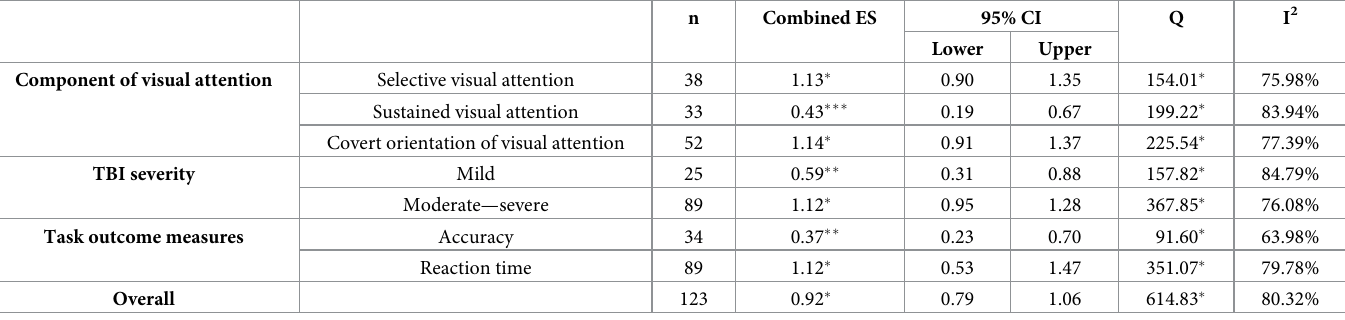
Visual attention following TBI. Table 4 reports the results of the overall ES and the com- bined ESs for different components of visual attention, TBI severity, and outcome measures, and these values are plotted in Fig 3. The 20 studies result in a total of 123 ESs represent differ- ent components of visual attention and conditions. The overall impact of TBI on visual atten- tion was significant and was large (ES = 0.92, SE = 0.09, p < 0.0001), but with significant